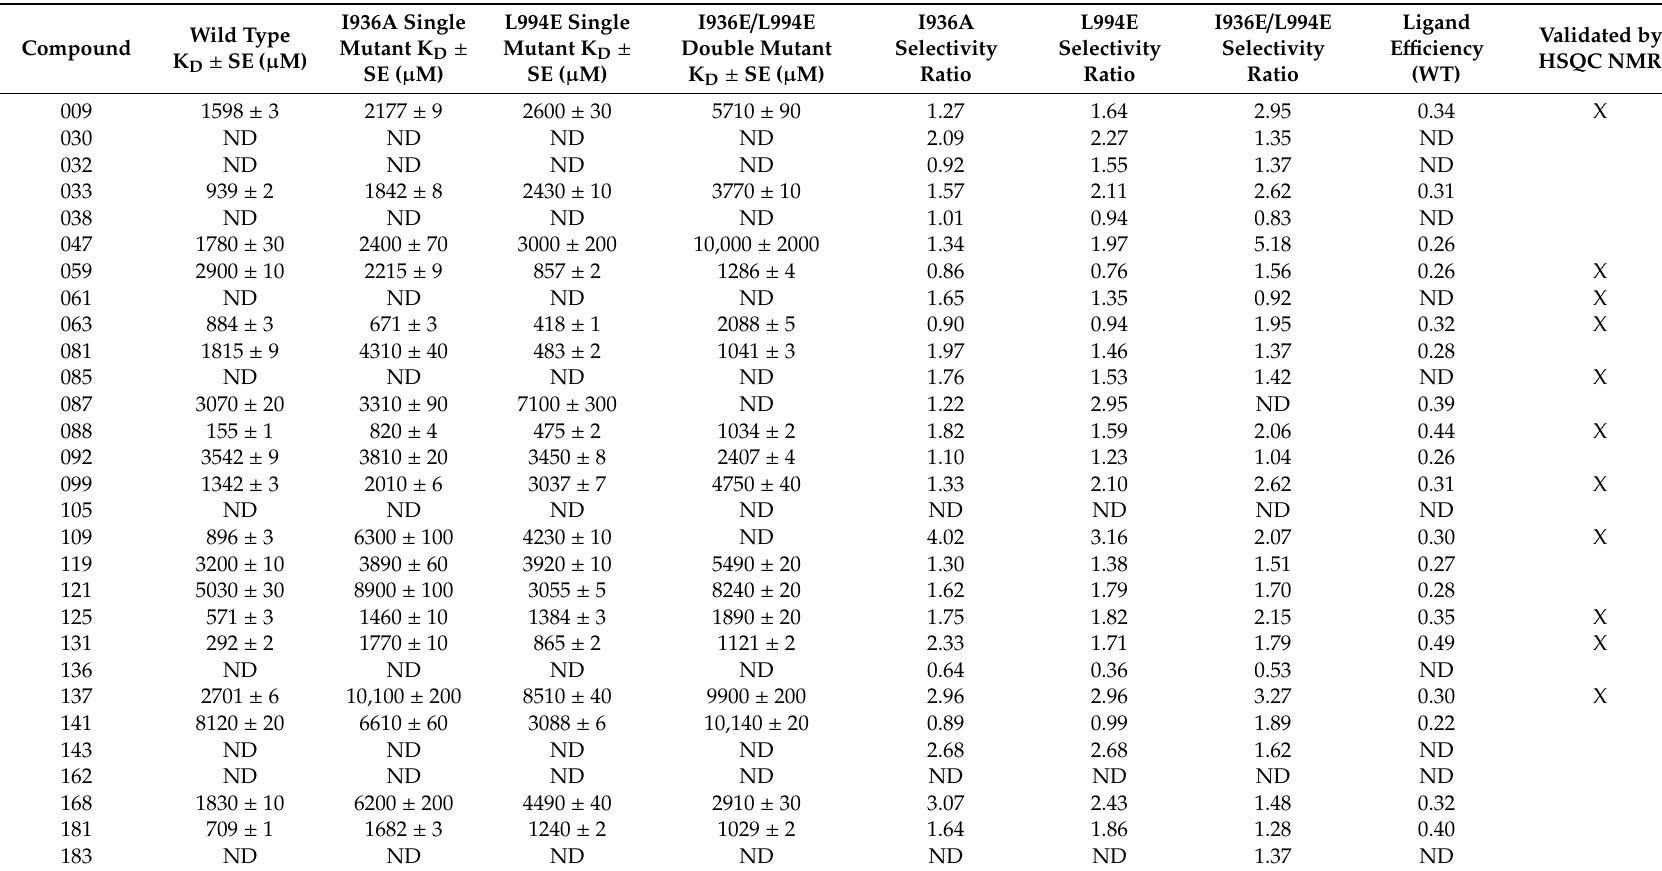
Table 1. Focal Adhesion Kinase (FAK) FAT binding a ffi nity, WT / Mutant selectivity ratio, ligand e ffi ciency, and HSQC-NMR validation for fragment hits on SPR